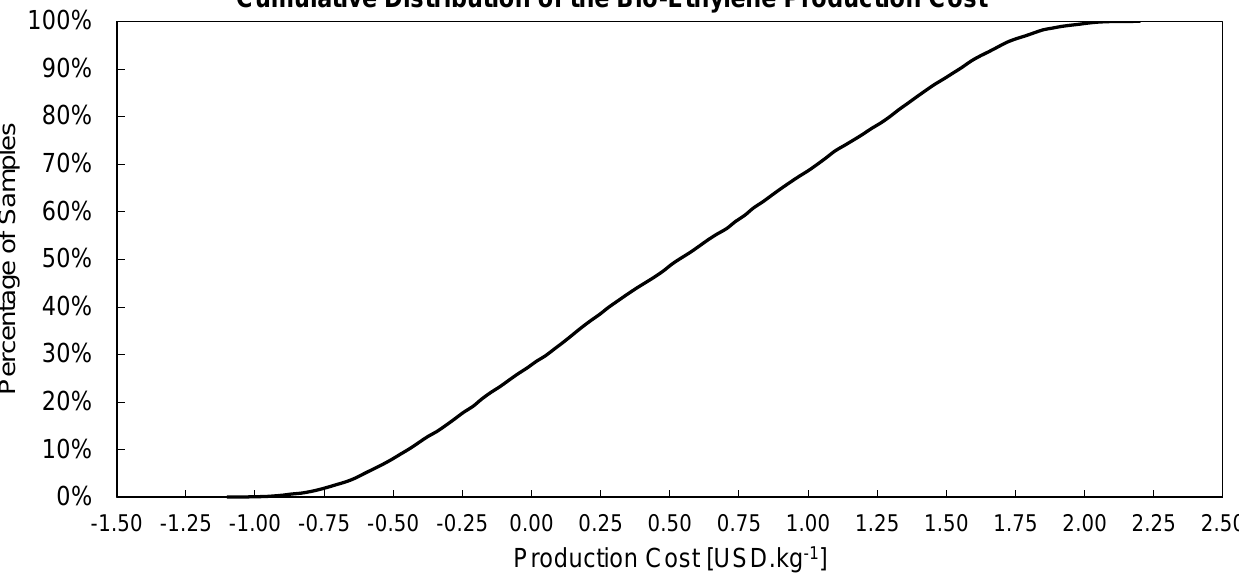
Figure 15. Cumulative distribution for the bio-ethylene production cost resulting from the Monte Carlo